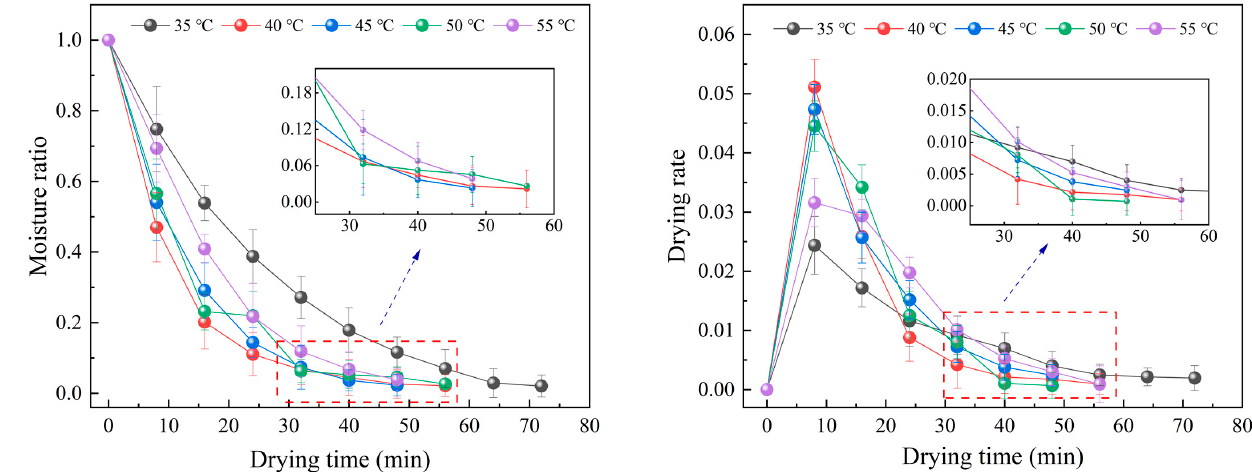
Figure 2. Effects of radiation temperature on drying curve and drying rate curve.